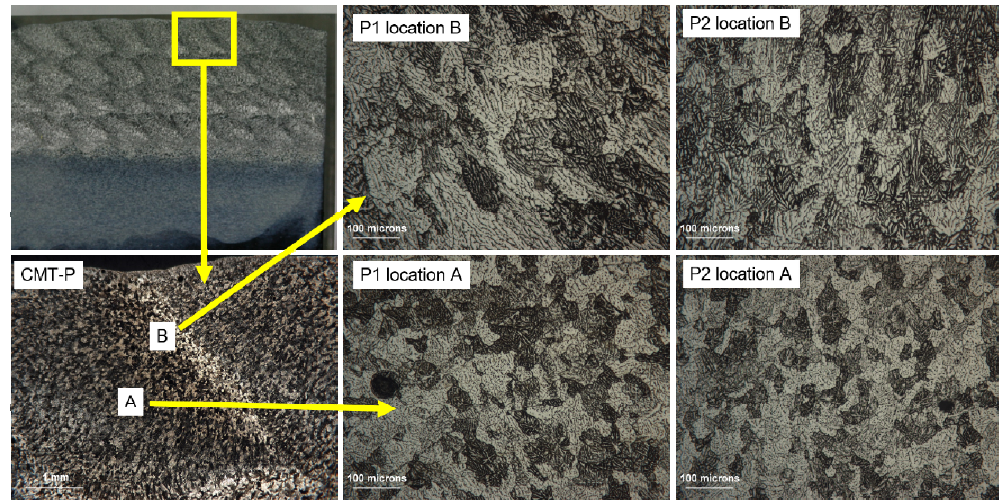
Figure 10. The microstructure of block samples formed with the CMT ‐ P process.